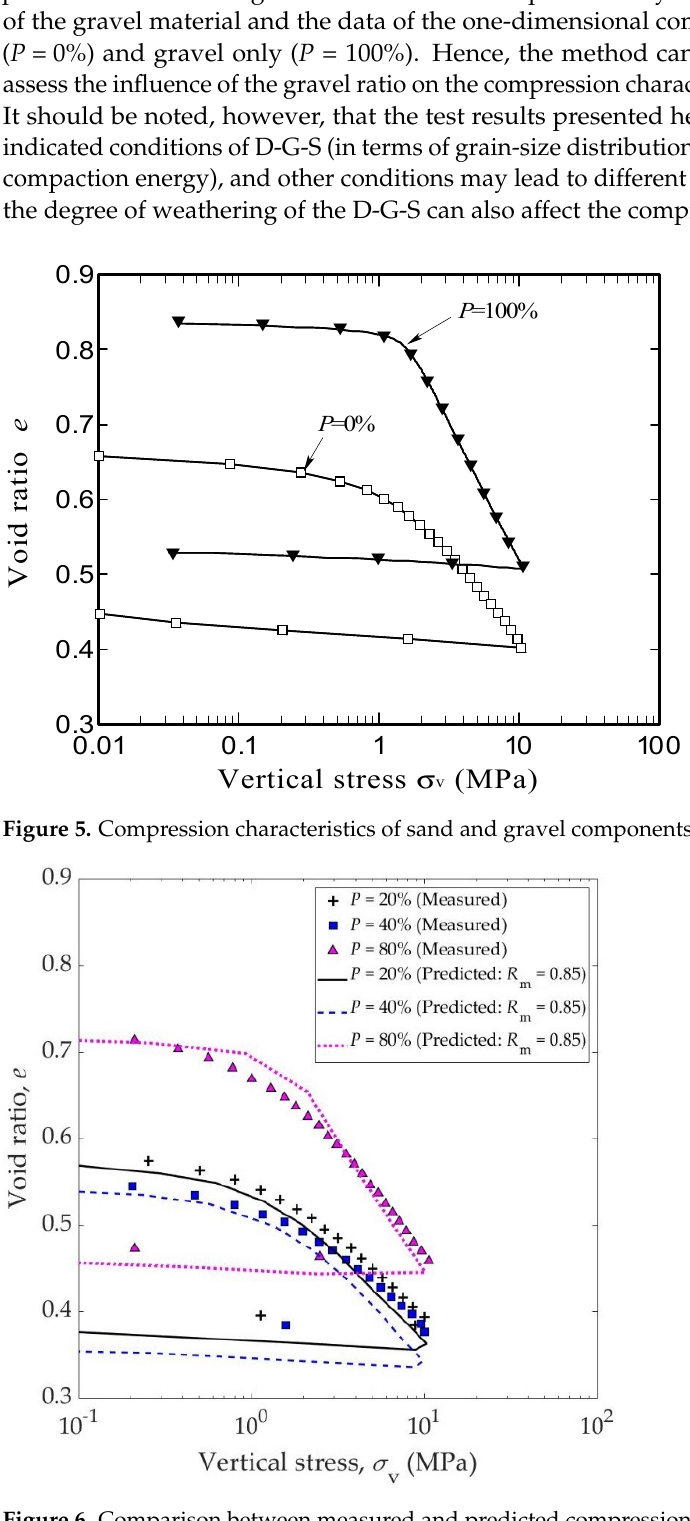
Figure 6. Comparison between measured and predicted compression curves for P = 20%, 40%, and 80% using an R m of 0.85.